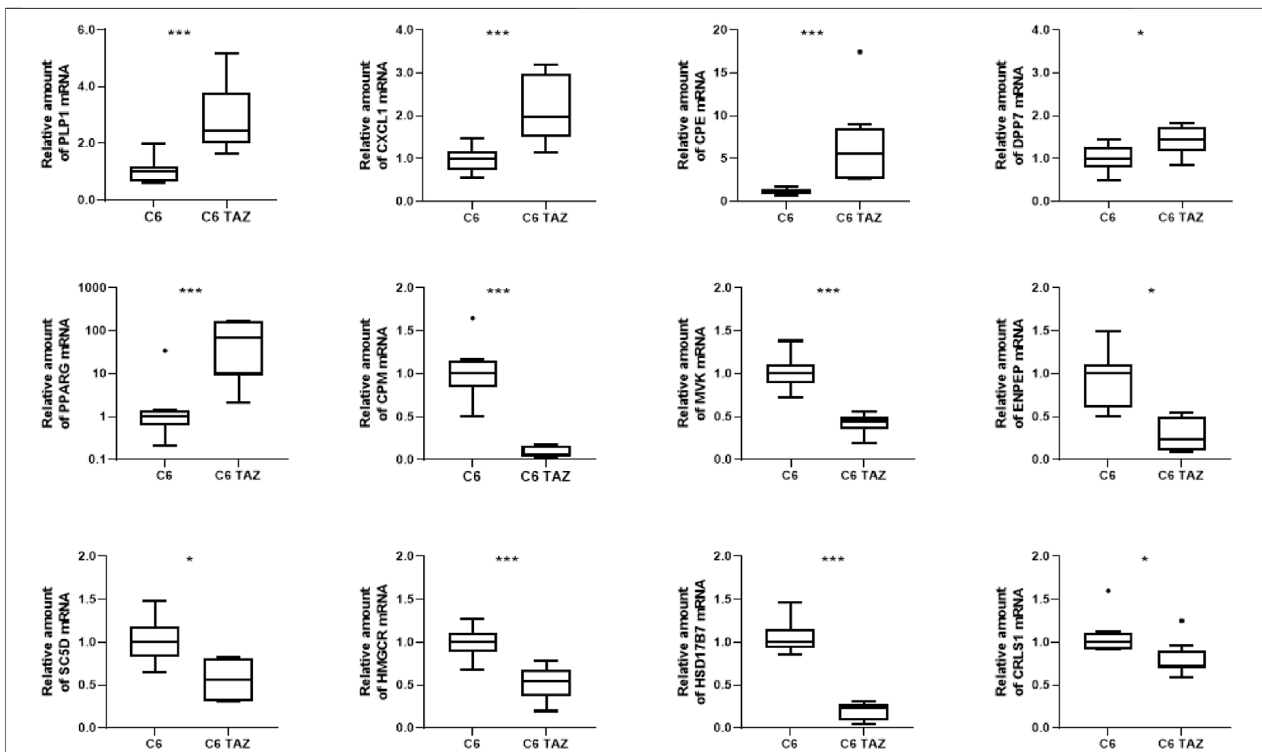
FIGURE2| Tafazzinde fi ciencyaltersgeneexpressioninC6cells:Quanti fi cationlevelsofindicatedgenesinC6andC6TAZcellswaspreformedandtheamountof mRNA was determined by using RT-qPCR and normalized to RPL13a. Data is given as boxplot with median, quartile, and interquartile range (* p < 0.05; ** p < 0.01; *** p < 0.001). Outliers are indicated using Tukey method. n =